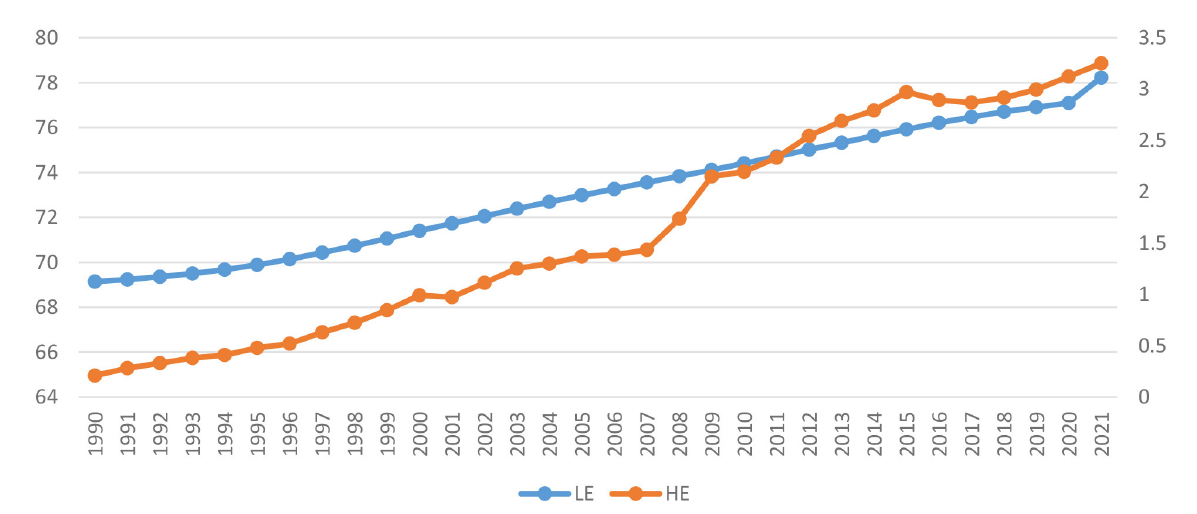
FIGURE1 Life expectancy (LE) and Health spending (HE) in China (1990–2021). Source: World Bank Development